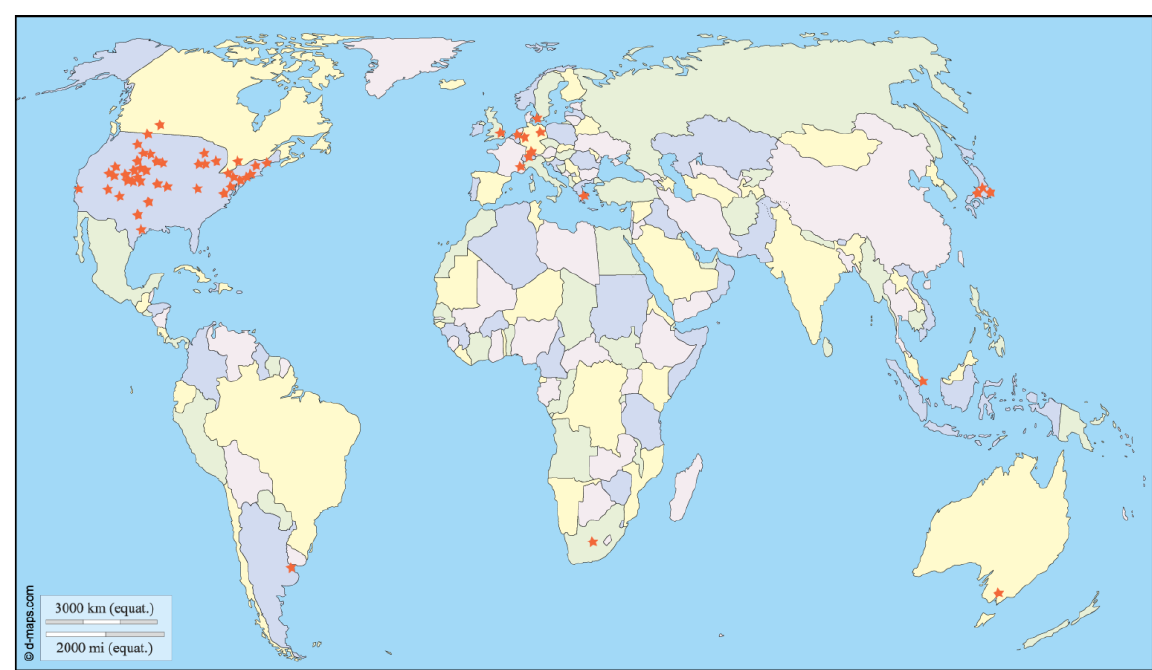
Figure 1 : Map showing the approximate locations of the museums and institutions housing sauropod specimens from the Morrison Formation. Map © d-maps.com, modified with permission. Original available here: https://d-maps.com/carte.php?num_car=126802&lang=en.